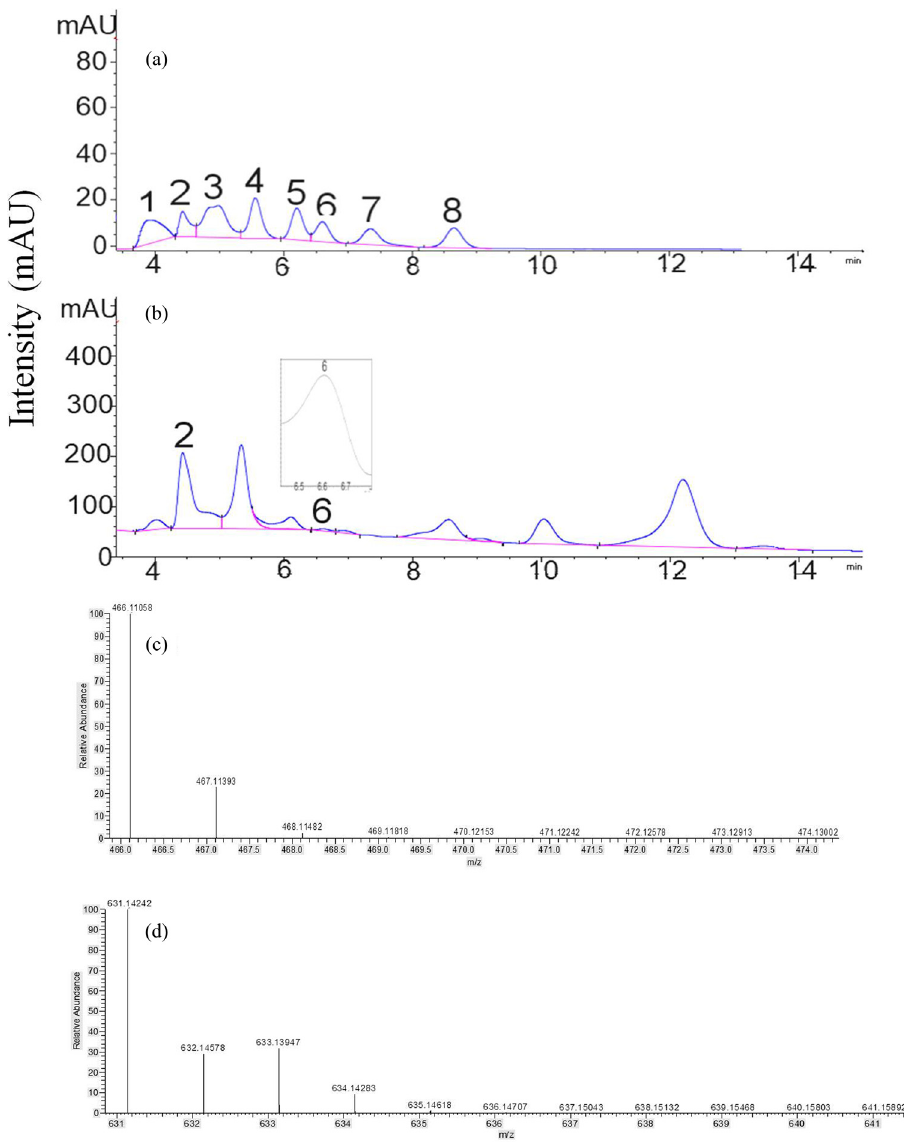
Figure 4: HPLC analysis of the main pigment components of peel extracts. HPLC chromatograms of standard solutions ( a ) and pigment extract samples ( b ) . Retention time of peak 2 and peak 6 were 4.43 and 6.61 min, respectively, for standards and pigment extract